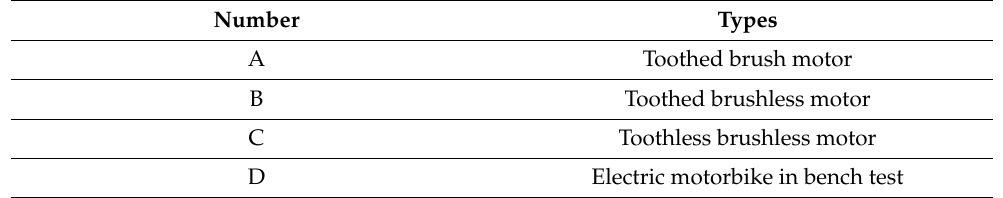
Table 2. Electrical vehicle specifications in the